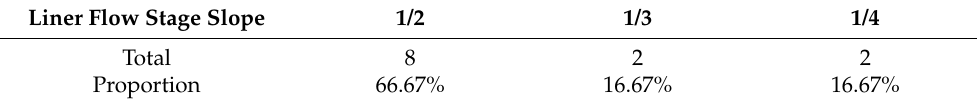
Figure 8. Horizontal well test curve with linear flow slope of 1/4.